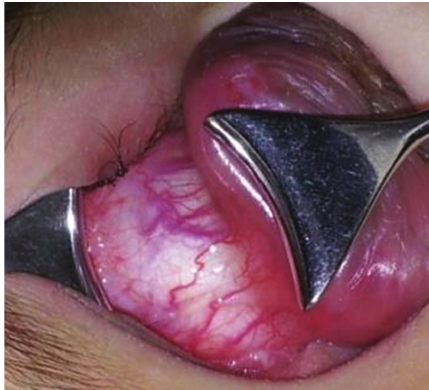
Figure 5: Mass adhered to the limbus and cornea but not to the rest of ocular surface of the left eye.